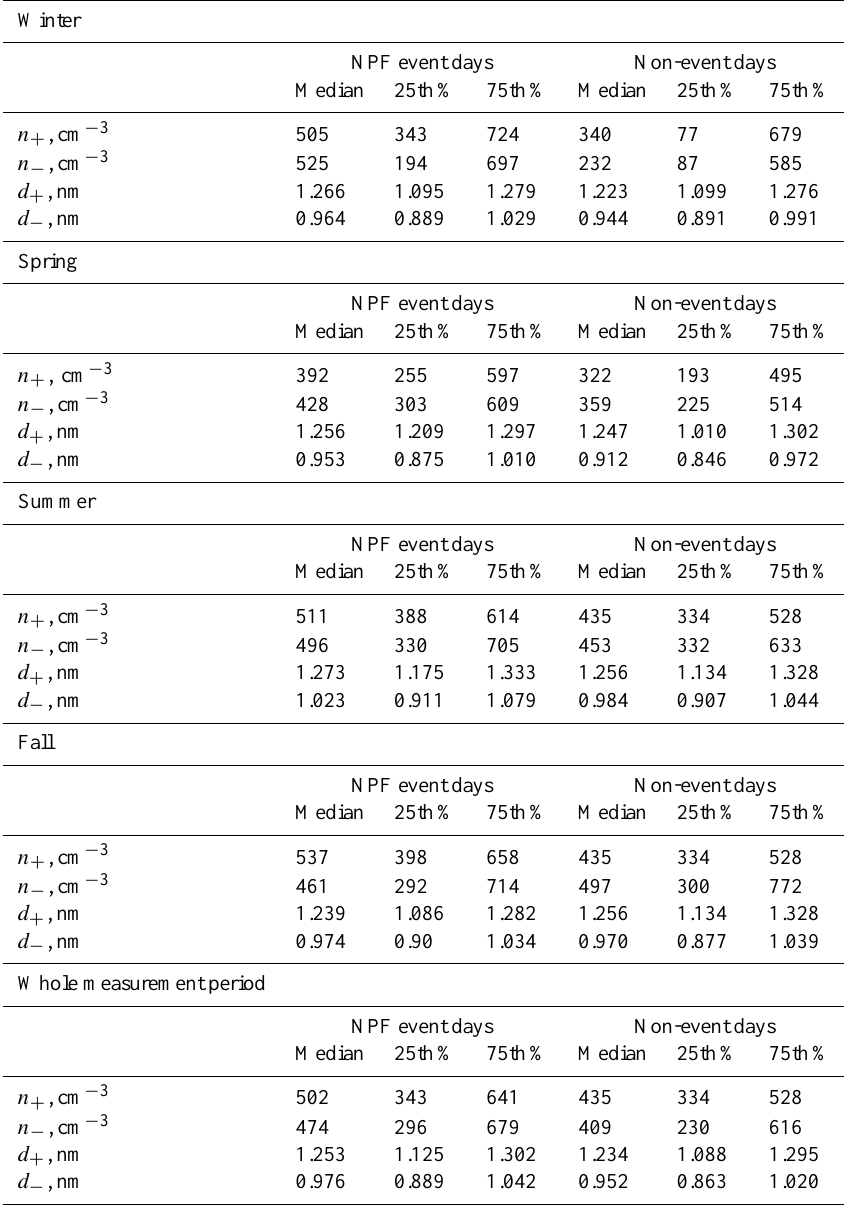
Table 3. Statistics of the positive and negative cluster ion mode (0.8–1.9nm) concentration ( n + and n − , respectively) and mean diameter ( d + and d − , respectively) in clear sky conditions. Calculations are based on hourly medians. February 2007–February 2012, Puy de